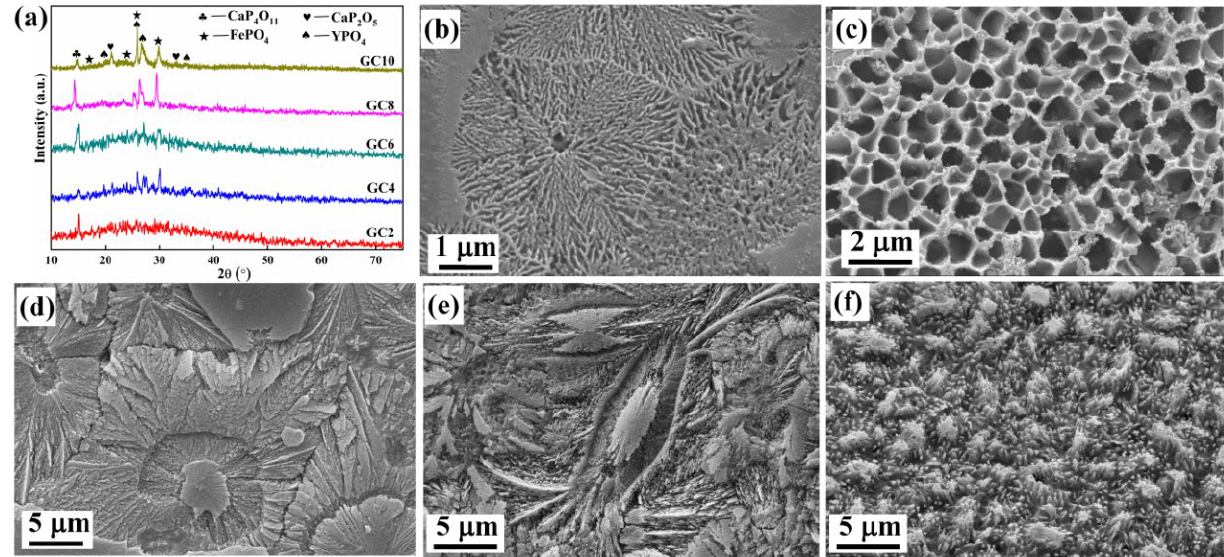
Figure 6. ( a ) The XRD patterns of yttrium phosphate glass samples for a crystallization time of 10 h. SEM images of ( b ) GC2, ( c ) GC4, ( d ) GC6, ( e ) GC8, and ( f ) GC10 samples after 40% HF etching for 15~20 s.